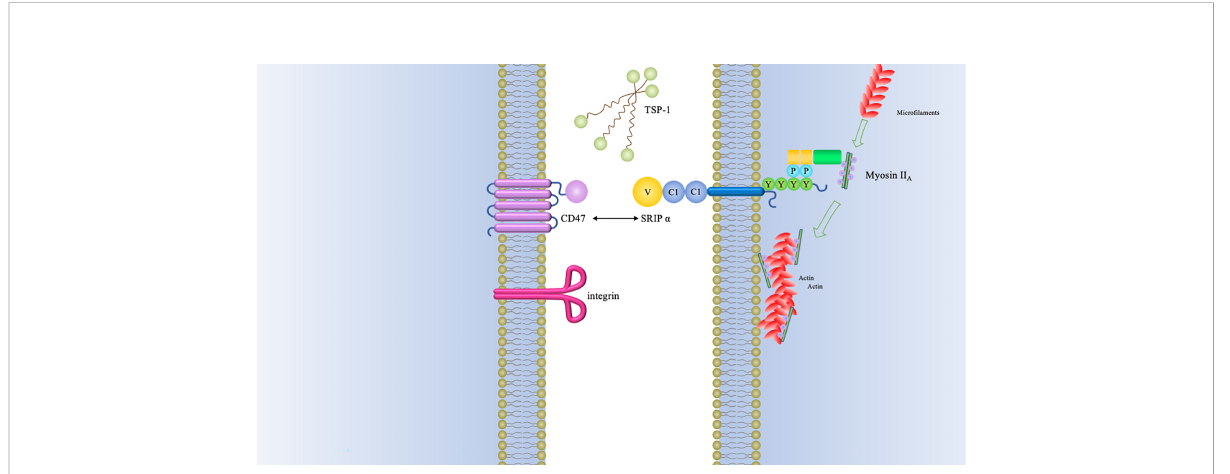
FIGURE 1 CD47 binding partners and downstream signaling mediators of CD47-SIRP a interaction.The type of signals triggered by CD47 relies on many factors, of which the foremost is the type of ligand that it binds. Three major groups of ligands are identi fi ed to exhibit capacity of binding to CD47, namely, SIRP a , TSP-1, and integrins. The interaction between CD47 and SIRP a causes cytoplasmic ITIM phosphorylation and subsequently recruits SHP-1/2. Both of SHP-1 and SHP-2 can inhibit accumulation of myosin-IIA at the phagocytic synapse, which fi nally inhibit the process of